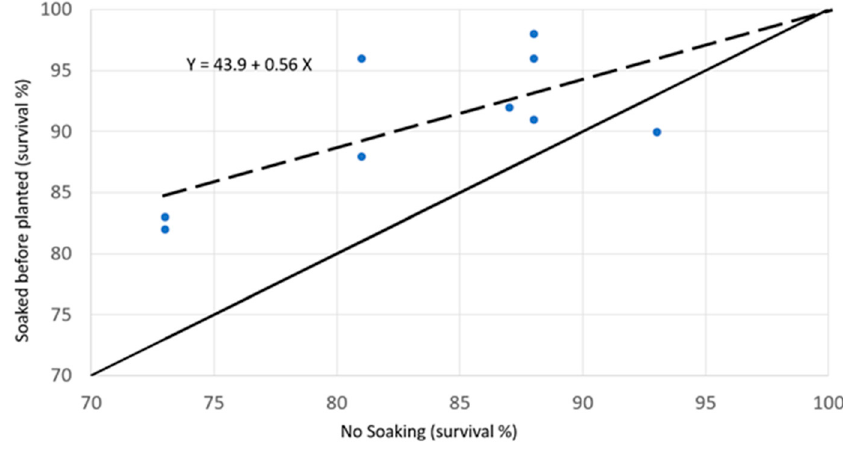
Figure 12. Loblolly pine seedlings were lifted and packed into bundles in January at the New Kent Nursery in Virginia (1979–1981). Seedlings were stored in an unheated garage for periods of 4 to 9 weeks. Just before planting, selected bundles were soaked in water for 1 h and then outplanted. Seedlings removed from other bundles were planted without any soaking. On average, soaking seedlings prior to planting increased survival by 7% [82]. Points above the solid line represent sites where soaking roots increased survival. Data from [82]. p > |t| = 0.046 for intercept and 0.036 for slope; R 2 = 0.48.